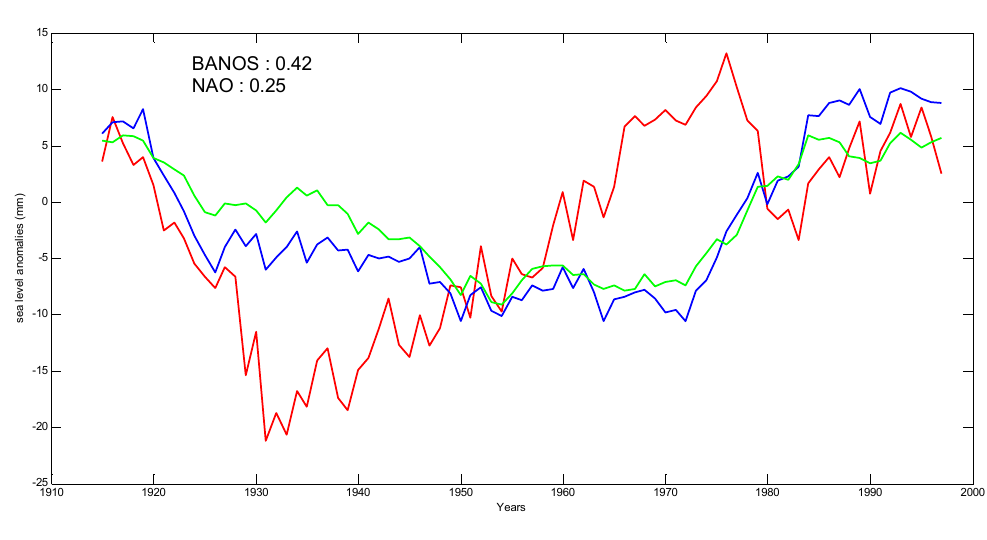
Figure 2. The 31-year running means of predicted (blue: the Baltic Sea and North Sea Oscillation (BANOS) index predicted; green: the NAO index predicted) and observed (red) sea levels of the Stockholm and Warnemünde stations (top panel is for Stockholm) together with the BSS values in the 31-year mean smoothed time series. Note the different y -axis scales. The numbers in the figure indicate the BSS